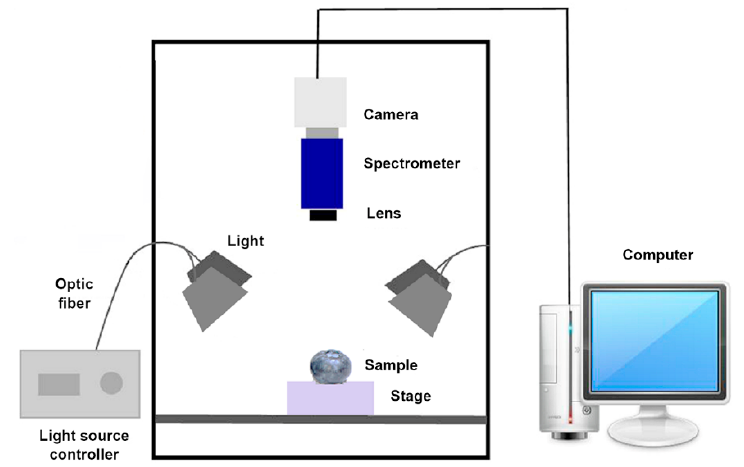
Figure 2. Schematic of the hyperspectral imaging system.